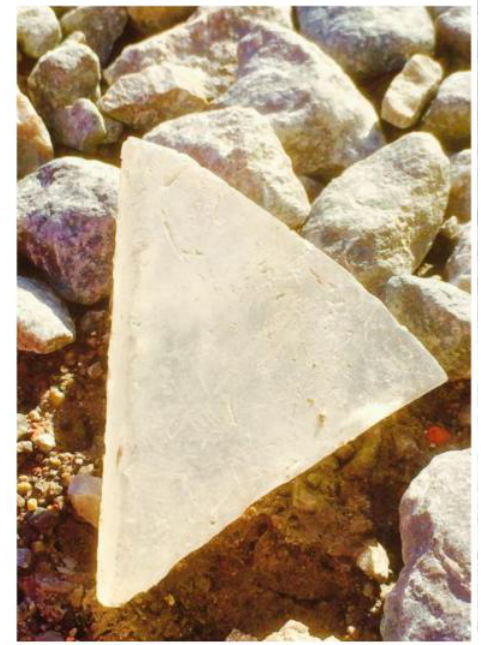
Figure 2. Perspex shard on Car Park